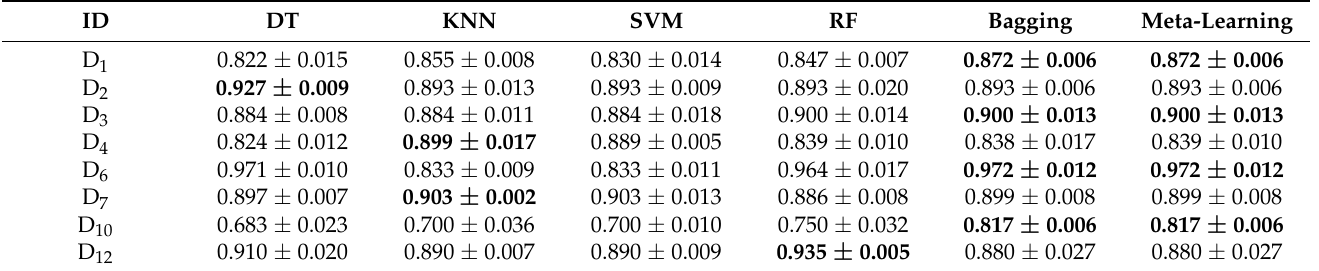
Table 5. Accuracy comparison between meta-learning and traditional ML algorithms in senaries.